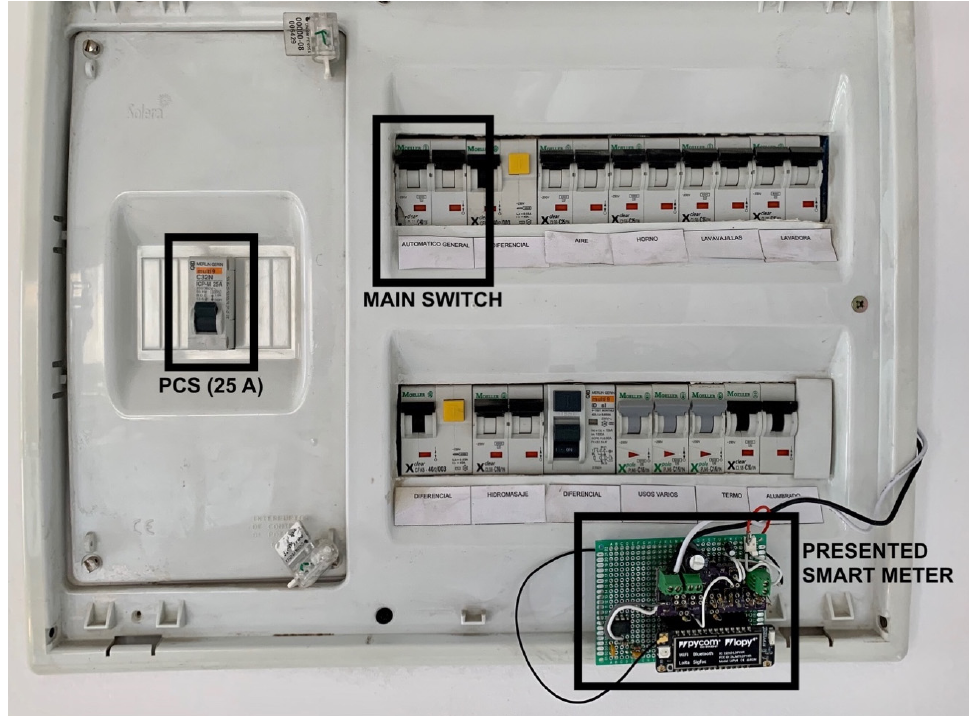
Figure 21. Installation of the device in the electrical panel of a household.